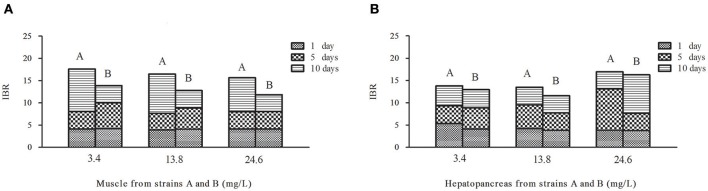
Temporal variation of IBR values in muscles (A) and hepatopancreas (B) of strains A and B under the stress of ammonia-N pollution. The word (A or B) above the column means strain A or strain B.